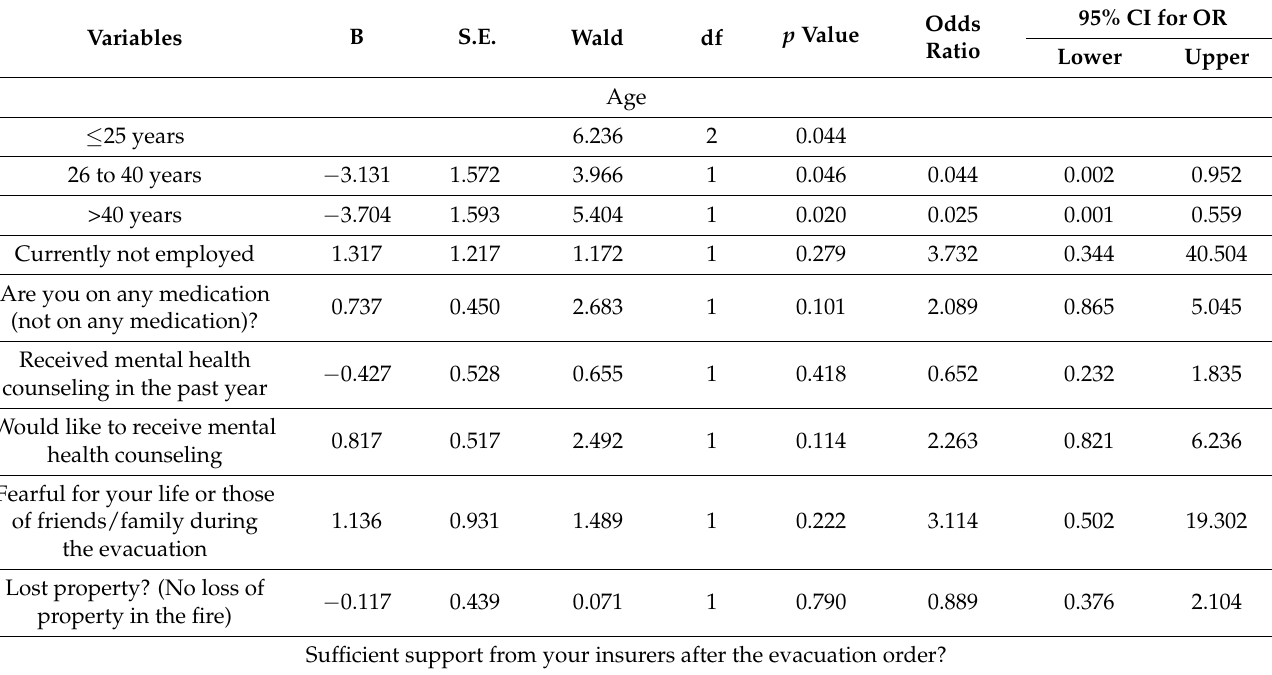
Table 3. Logistic regression model for respondents’ likelihood of presenting with high-to normal resilience and low